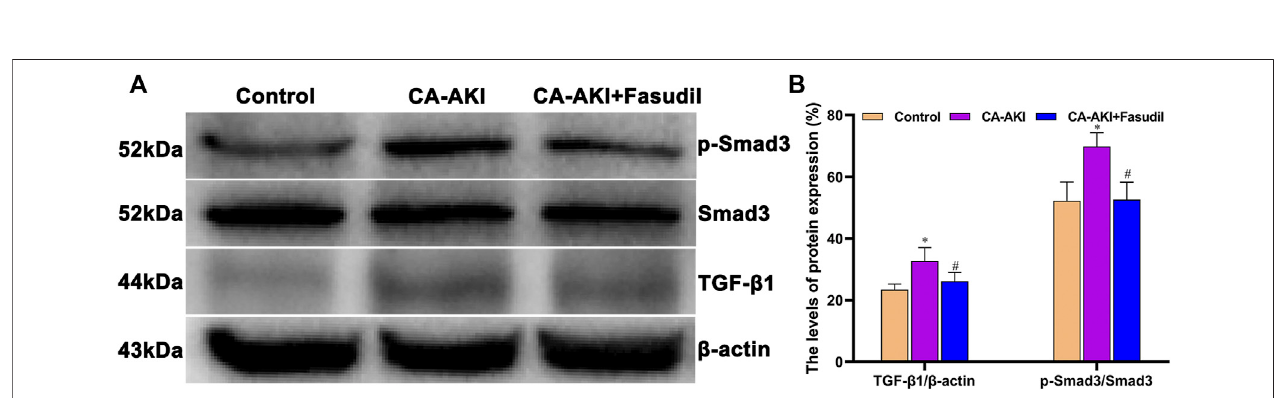
FIGURE 10 | TGF- β 1/Smad3 expression in three animal groups: (A) expression levels of TGF- β 1, Smad3, and p-Smad 3 by group (western blot) and (B) relative densitometry analysis of protein ratios.* p < 0.05 between CA-AKI/CA-AKI + Fasudil and controls; # p < 0.05 between CA-AKI + Fasudil and CA-AKI.